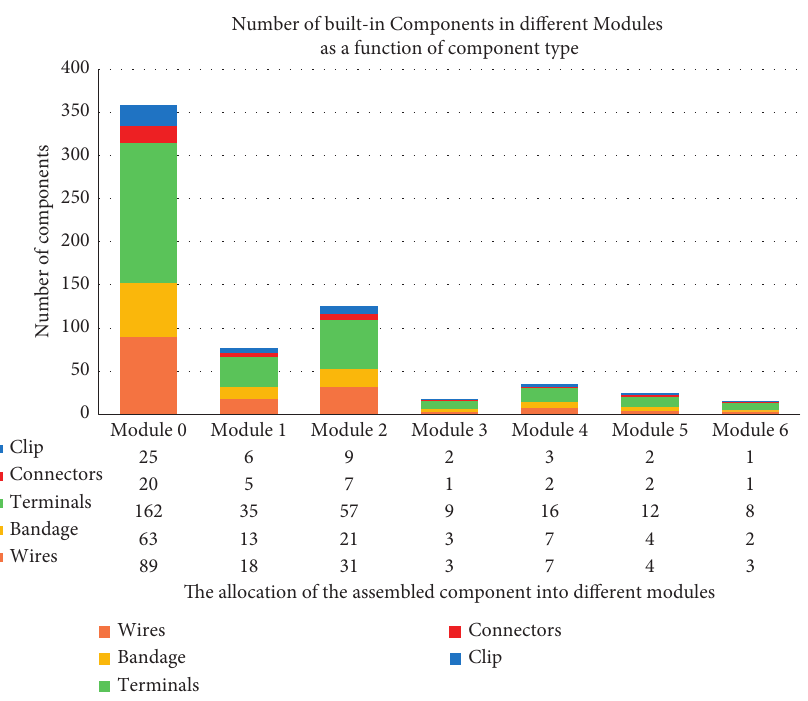
Figure 16: Results of the SPARQL query regarding built-in components in different